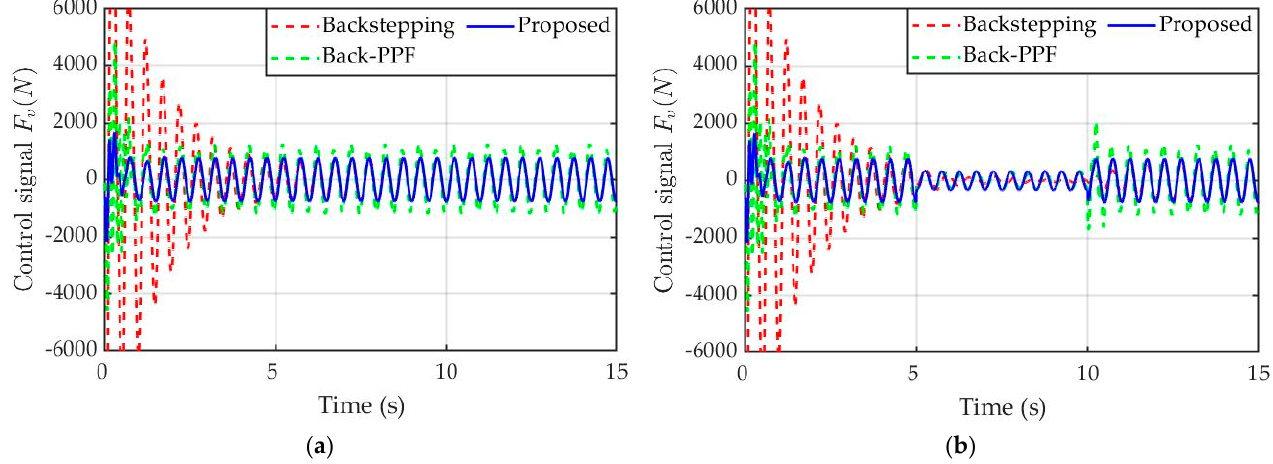
Figure 9. Control signals